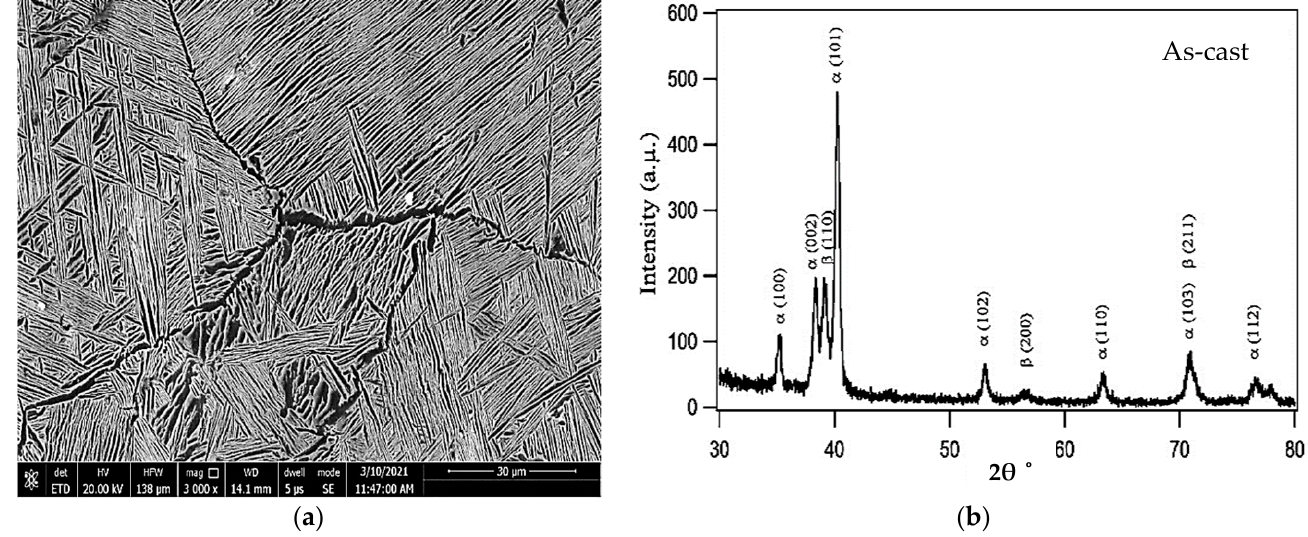
Figure 2. ( a ) FESEM micrograph of the as-cast TC21 alloy and ( b ) XRD pattern of the as-cast TC21 alloy.